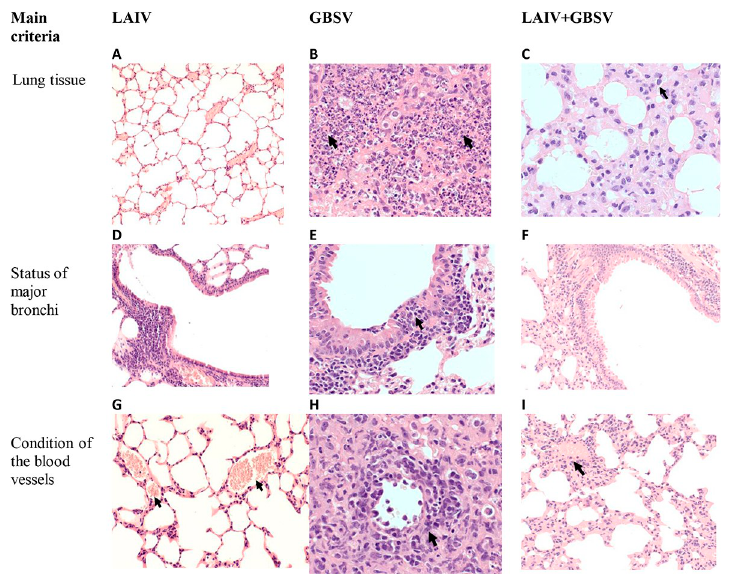
Fig 5. Comparative study of pathological changes in the lungs of mice at 48 hours after serial A/Shanghai/2/2013 (H7N9) CDC-RG and S . pneumoniae infections. (A) Magnification, × 100; B,C,E,Y– 400. (D,F,G,I)Magnification, × 200. The meanings of the arrows are indicated in the